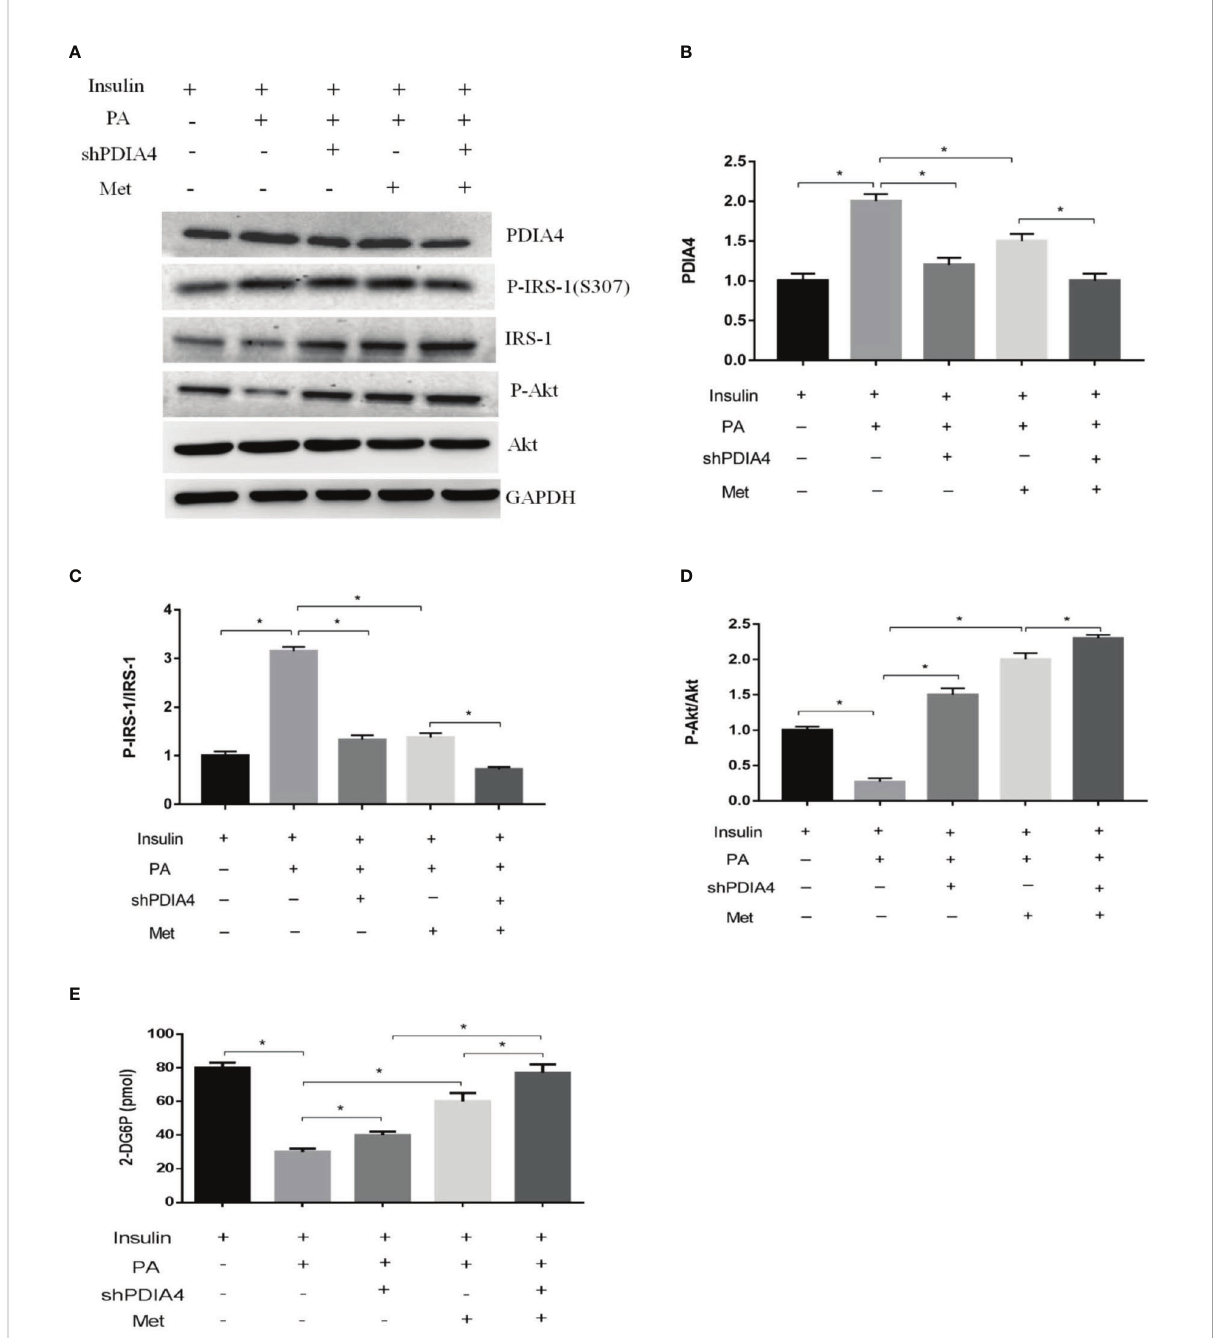
FIGURE 5 Metformin and PDIA4 knockdown in palmitate-induced IR and glucose uptake in C2C12 cells. (A) The PDIA4 knockdown of C2C12 myotubes treated metformin with palmitate and insulin, then estimated PDIA4, p-IRS-1(307), p-Akt by western blotting. (B-D) Quantization from western blot PDIA4, p-IRS-1(307), p-Akt. (E) 2-Deoxyglucose (2-DG) uptake was assessed knockdown PDIA4 in C2C12 myotubes treated metformin with palmitate and insulin. All data are presented as the mean ± SD (n = 3 for each group). *P <